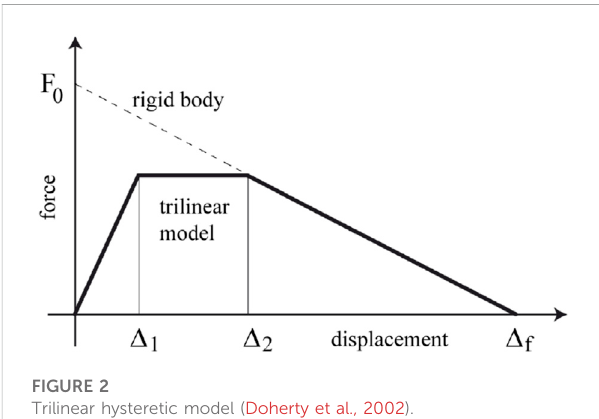
FIGURE 2 Trilinear hysteretic model (Doherty et al.,